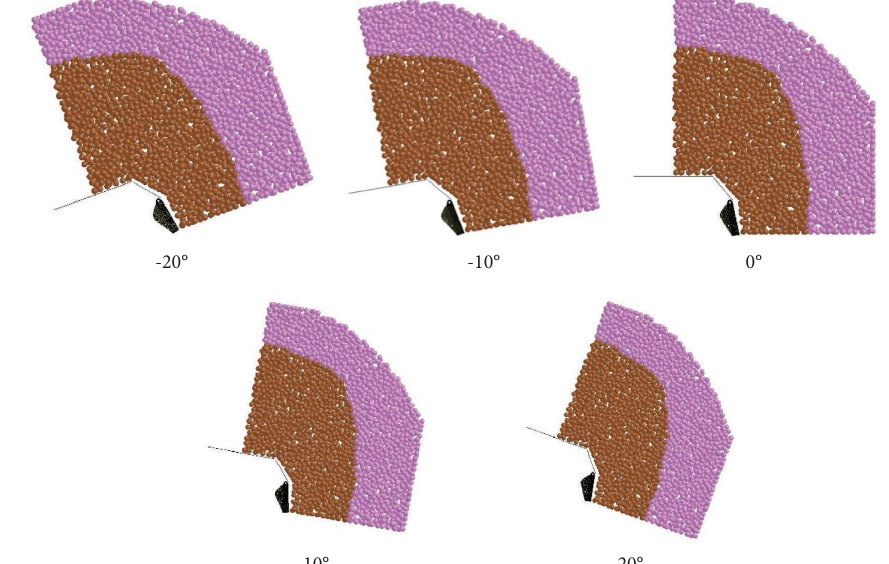
Figure 25: State before coal caving at diferent pitching